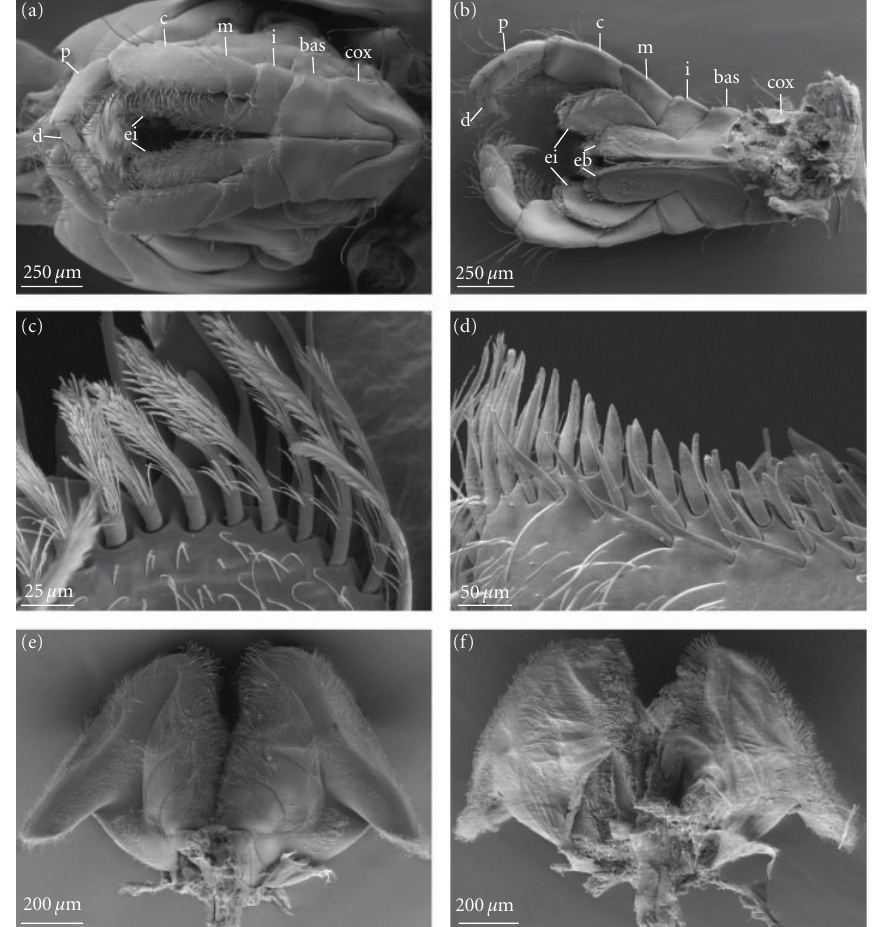
Figure 5: SEM images of maxillipeds and paragnaths of Gammarus pulex : (a) maxillipeds in posterior view; (b) maxillipeds in anterior view; (c) distal setation of endite of left basipod in anterior view (cf. eb in (b)); (d) median setation of endite of right ischium in posterior view (cf. ei in (a)); (e) paragnaths in posterior view; (f) paragnaths in anterior view. Abbreviations other than in previous figures: eb: endite